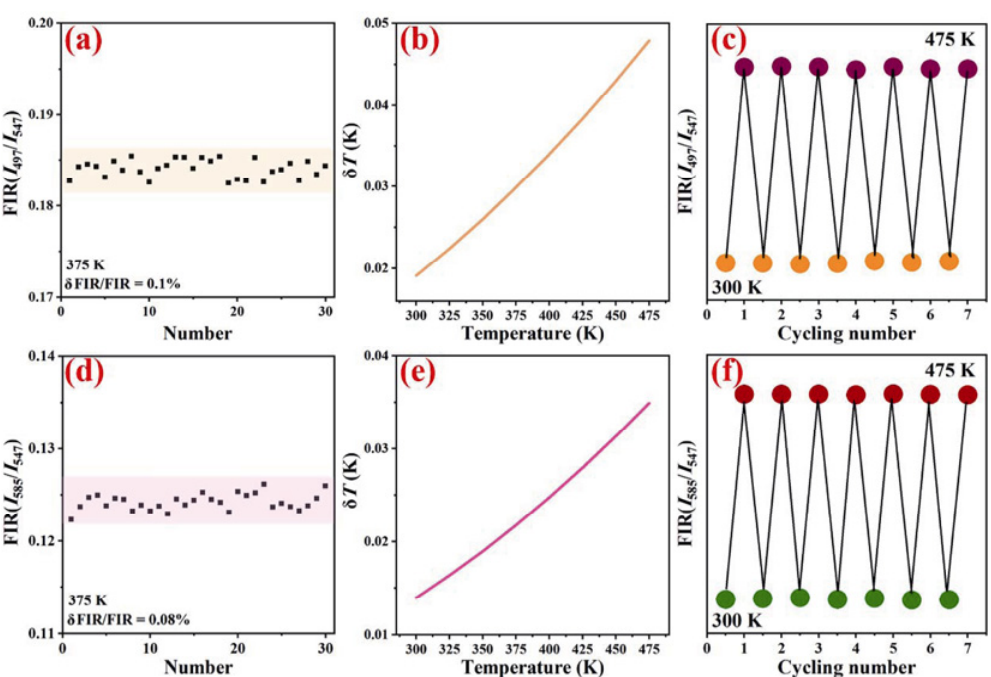
Fig. 8 (a) Thirty measurements of FIR( I 497 / I 547 ). (b) δ T of FIR( I 497 / I 547 ). (c) Thermal repeatability of FIR( I 497 / I 547 ) between 300 and 475 K. (d) Thirty measurements of FIR( I 585 / I 547 ). (e) δ T of FIR( I 585 / I 547 ). (f) Thermal repeatability of FIR( I 585 / I 547 ) between 300 and 475